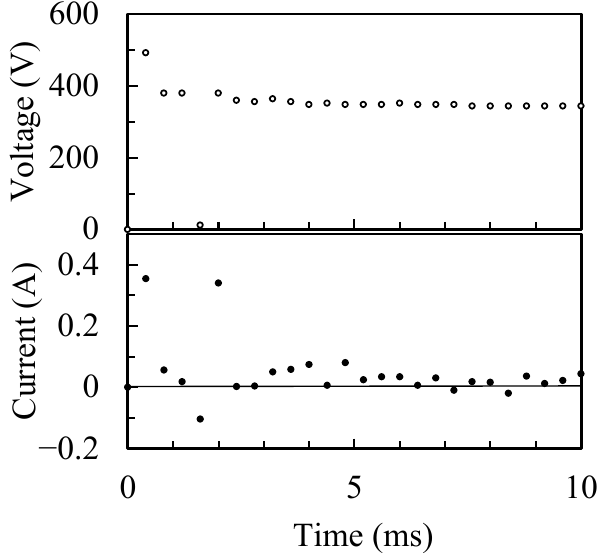
Figure 8. Time variation of voltage and current during the PEO process by ST operation.